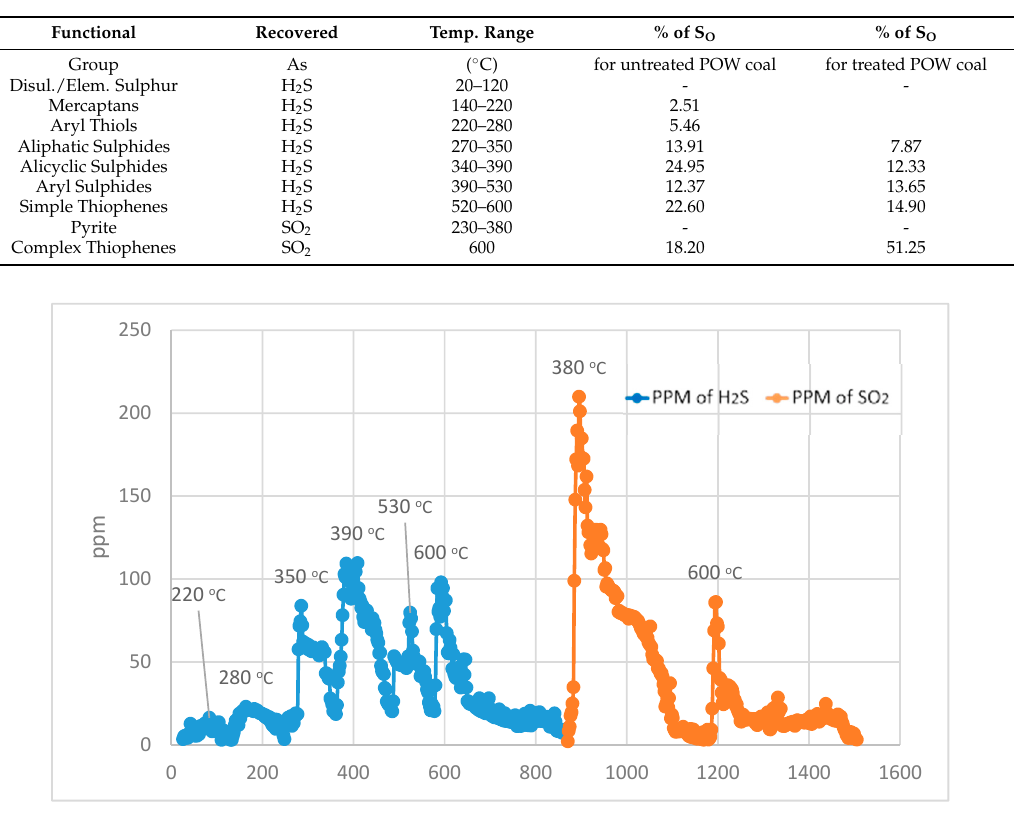
Figure 10. TPI of untreated POW coal.